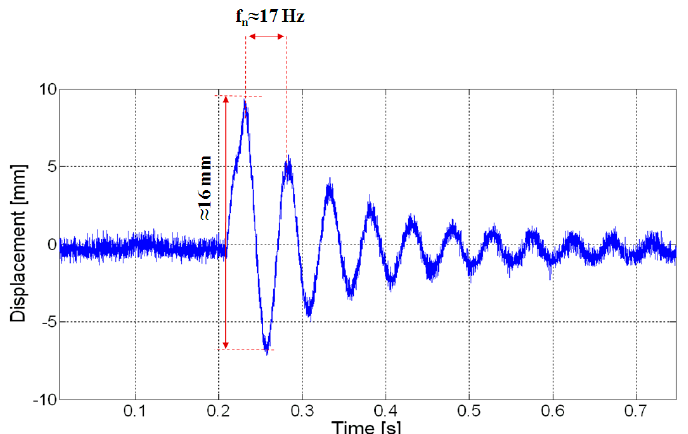
Figure 6. Displacement evaluated at the tip of the beam in the presence of a mechanical step impressed through the shaker.